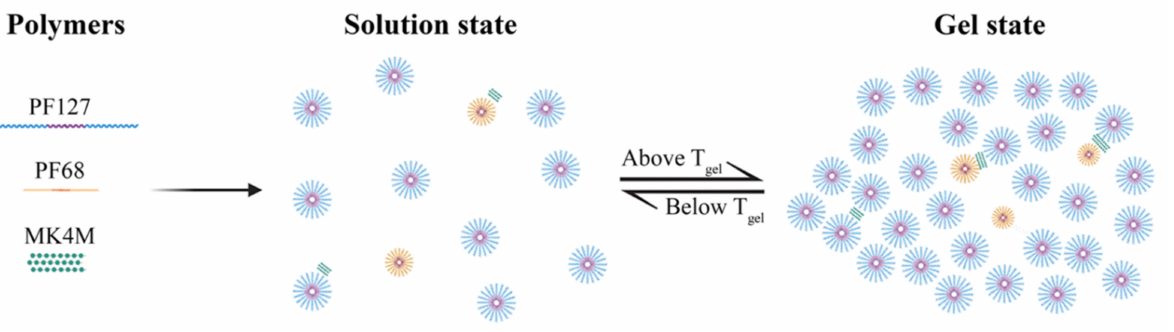
Figure 2. Potential structural formula of the formulated ternary hydrogel based on Pluronic ® F127, Pluronic ® F68, and hydroxypropyl